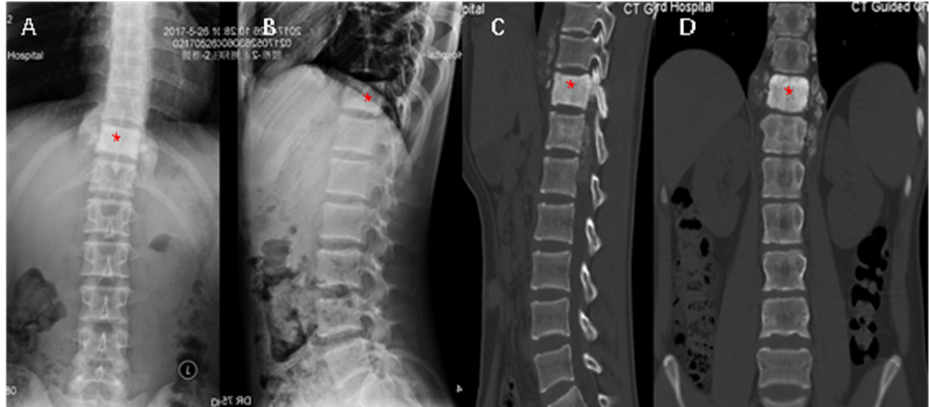
Figure 1. X-ray films ( A,B ) and CT images ( C , D ) showed the high-density osteogenic changes (* in red) in the T11 vertebrae body ( A – D ) and appendages ( C , D ), and those involved with the upper and lower stages of the spinal canal ( C , D ).